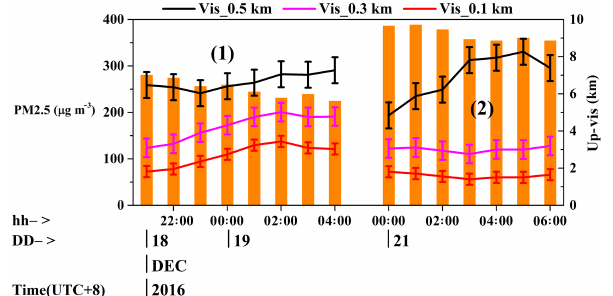
Figure 8. Hourly variation of Up-Vis and PM 2 . 5 mass concentration during certain periods.